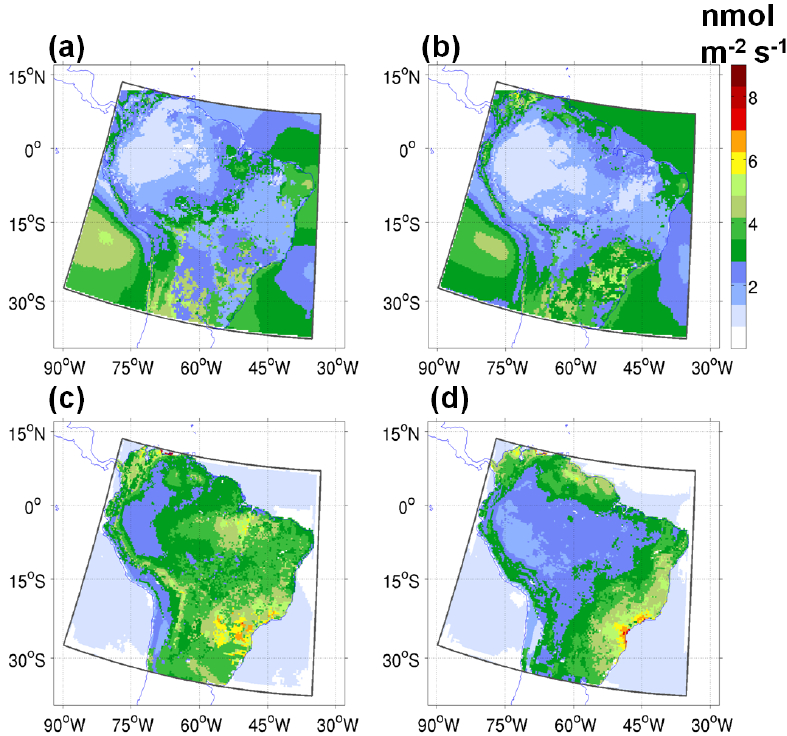
Figure 18. Average O 3 dry deposition flux (nmolm − 2 s − 1 ) as simulated on the 35km resolution domain (dark gray outline) by the CCATT- BRAMS model for (a) November 2008 and (b) May 2009 and by the WRF-Chem model for (c) November 2008 and (d) May 2009.